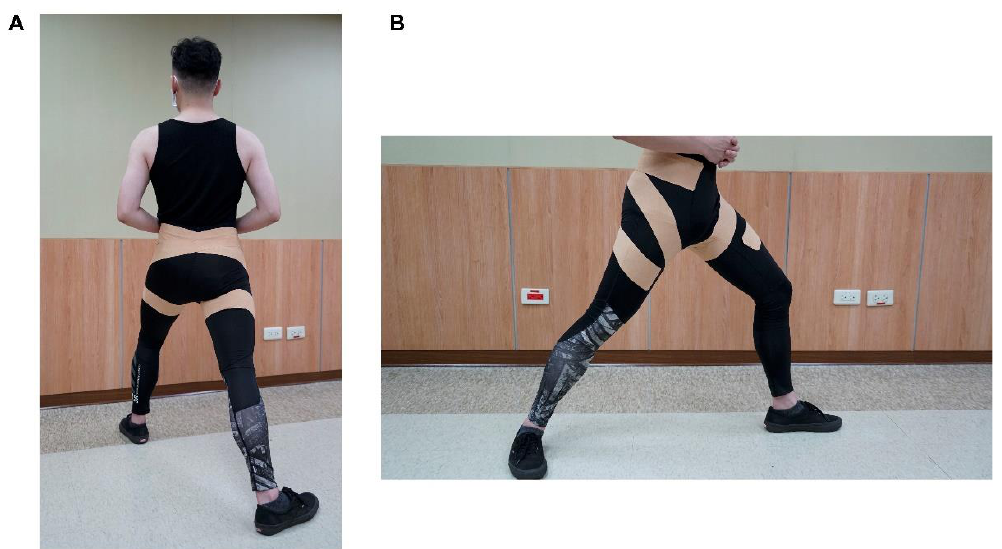
Figure 2. Demonstration of the dynamic tape applied on the bilateral hip. ( A ) Posterior view, ( B ) side view. The dynamic tape started from the vastus medialis obliquus and wrapped around the thigh in a superolateral direction to the posterior thigh, went to the proximal medial thigh, and then wrapped the thigh below the anterior superior iliac crest in a superolateral direction. After that, the dynamic tape crossed the low back to the contra-lateral lower quarter abdomen. The dynamic tape was applied on both hip joints.